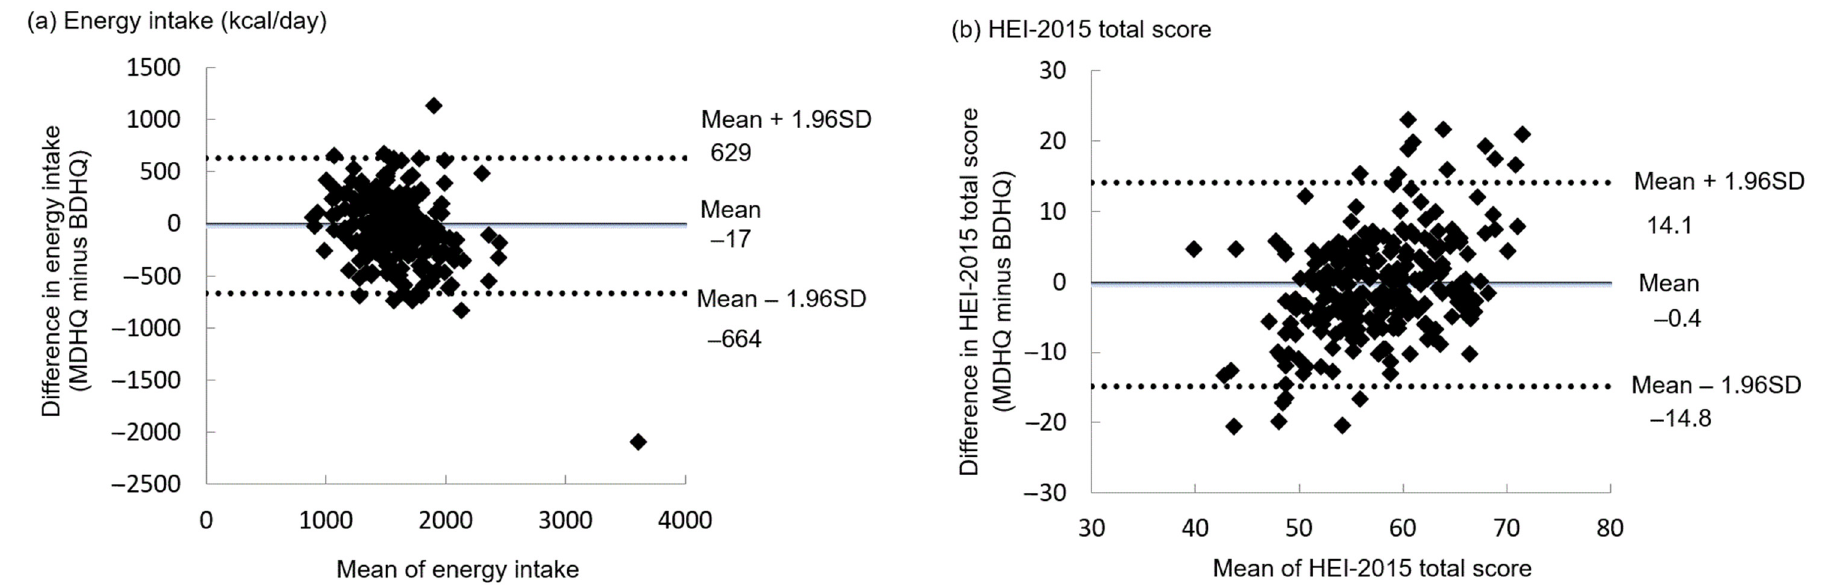
Figure 3. Bland–Altman plots assessing the agreement between the Meal-based Diet History Questionnaire (MDHQ) and Brief-type Diet History Questionnaire (BDHQ) in terms of ( a ) energy intake and ( b ) the Healthy Eating Index-2015 (HEI-2015) total score ( n = 255). SD, standard deviation.